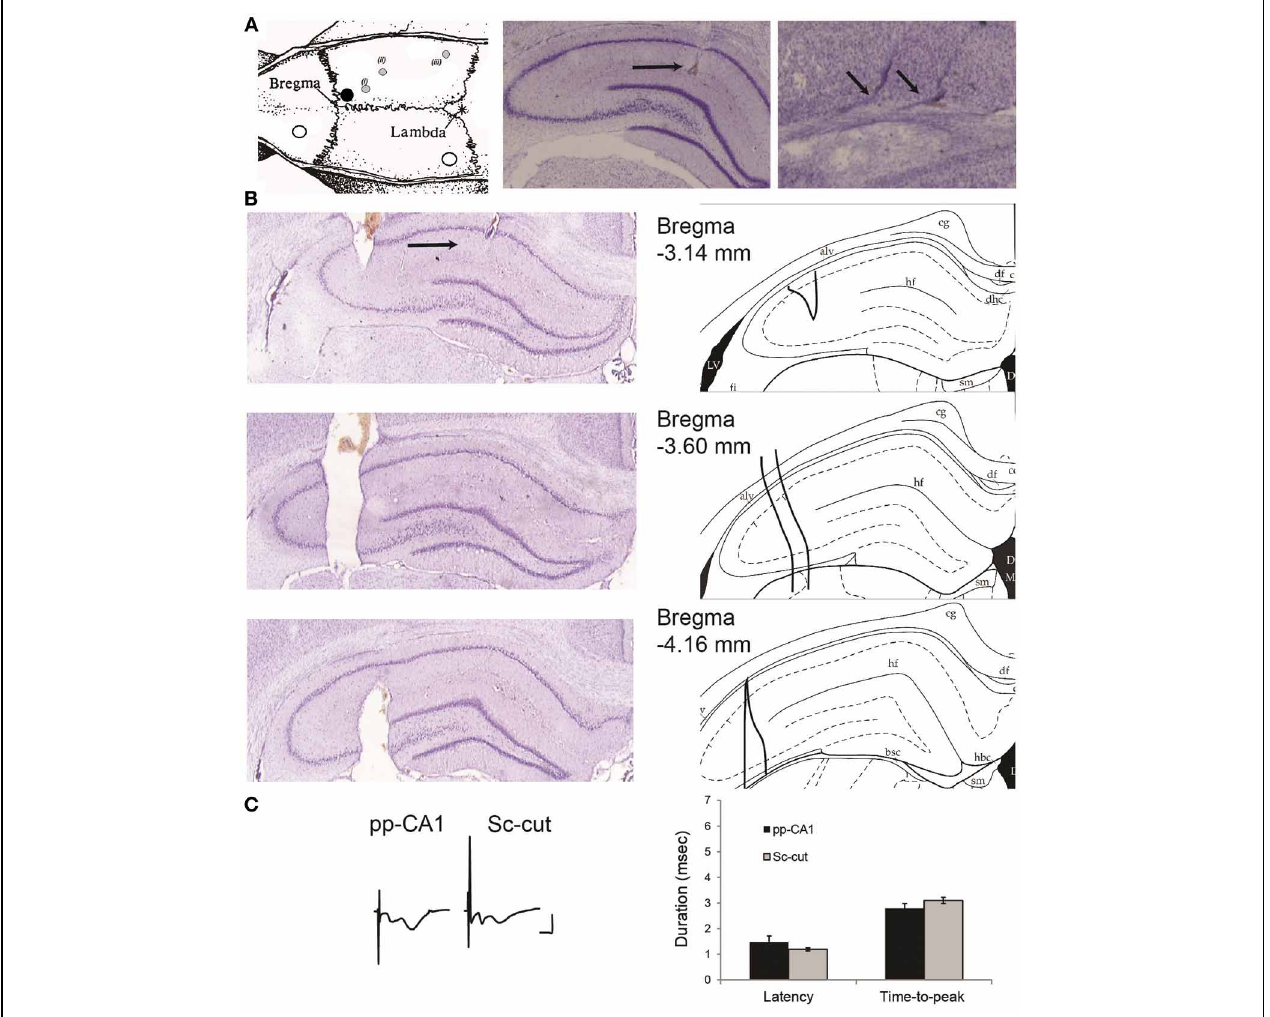
FIGURE 1 | (A) Location of the drilled holes on the rat skull and electrodes. Left: the white circles indicate the position of the ground and reference screws. The black circle signifies the position of the guiding cannula that reaches the lateral ventricle. The gray circles show the planar position of (i) the recording electrode, (ii) the stimulating electrode for Schaffer collaterals and (iii) the stimulating electrode for the perforant path (angular bundle) [Modified from Paxinos and Watson (1998)]. The animals were implanted with a stimulation electrode either in the Schaffer collateral (Sc) fibers (ii) or angular bundle (iii) if not indicated otherwise. Middle: location of the recording electrode for the perforant path (pp)-CA1 synapse (black horizontal arrow). Right: tracks of a bipolar stimulating electrode at the angular bundle